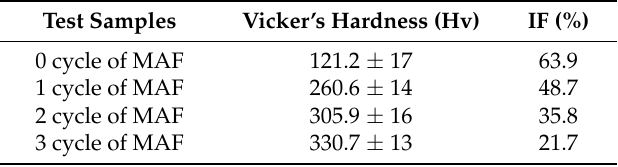
Table 2. Inhomogeneity factor (IF) of Ni 200 alloy at different MAF cycles.